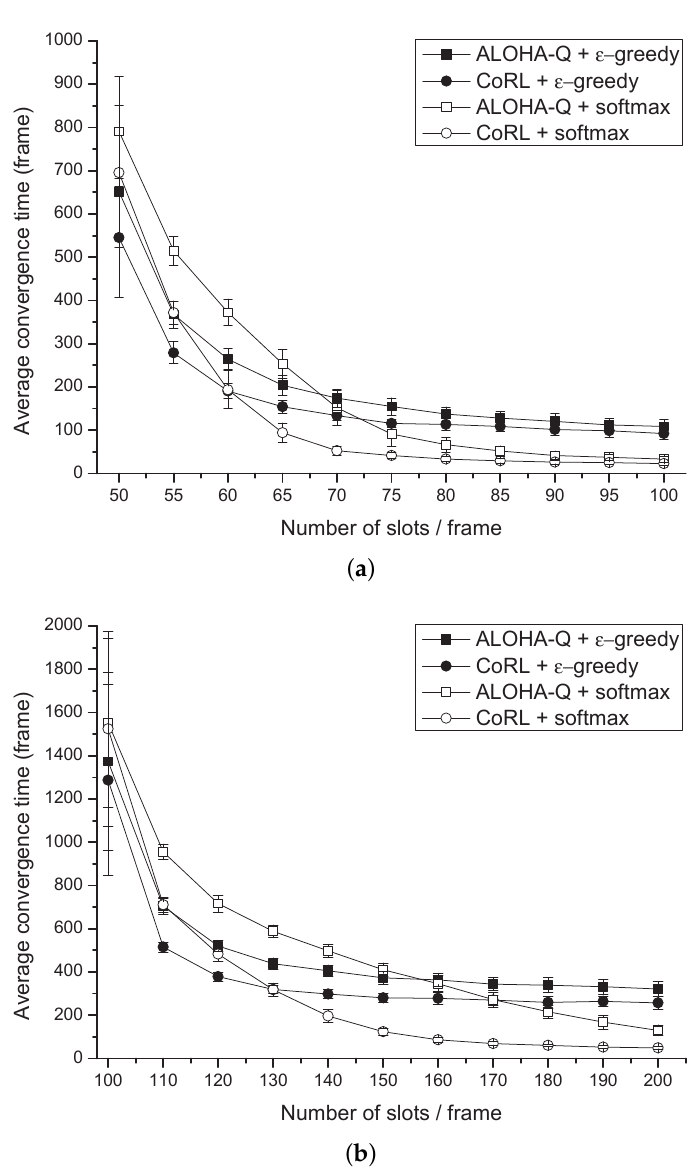
Figure 4. ( a , b ) Measures the results of average convergence time when a half of nodes serves prioritized packets. A network of ( a ) contains the 50 nodes, and the frame contains 50 slots up to 100 slots. A ( b ) network consists of 100 nodes, and the frame is deployed 100 slots up to 200 slots. ( a ) 50 nodes with prioritized services. ( b ) 100 nodes with prioritized